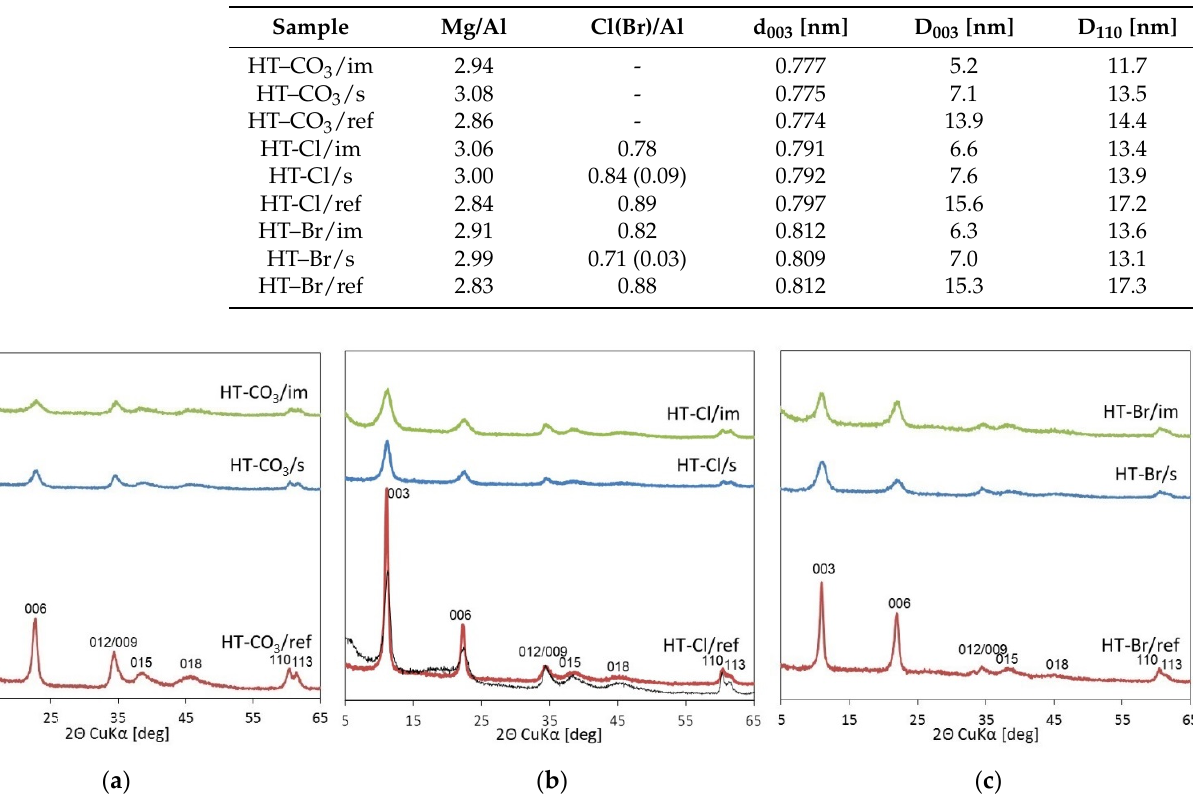
Figure 2. Powder XRD patterns of synthesized HT materials: ( a ) carbonate forms; ( b ) chloride forms (black trace—spent catalyst); ( c ) bromide forms.